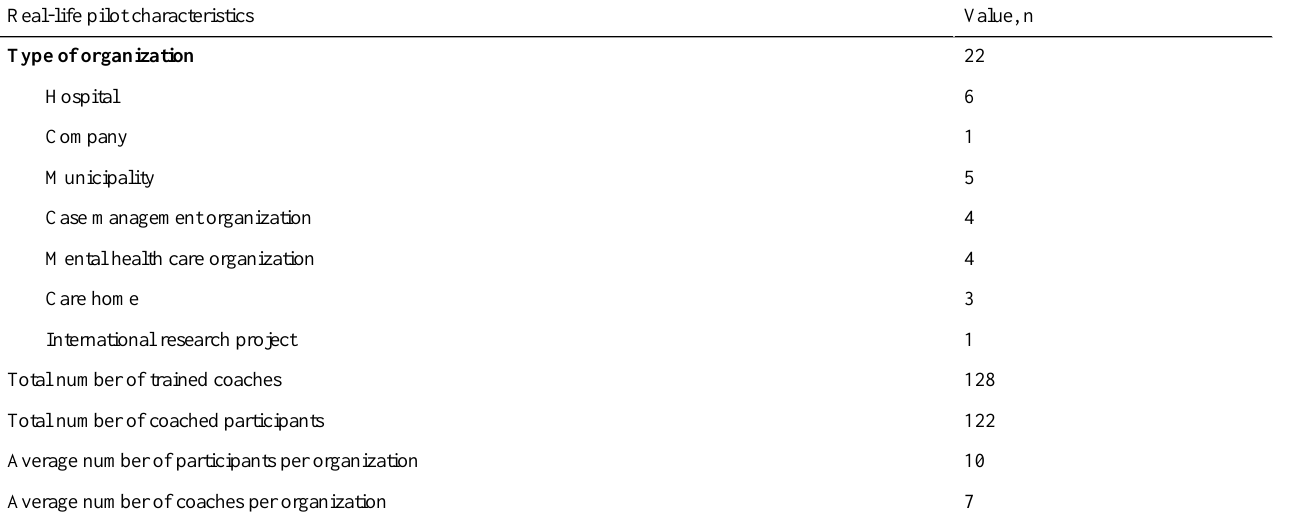
Table 1. Overview of real-life